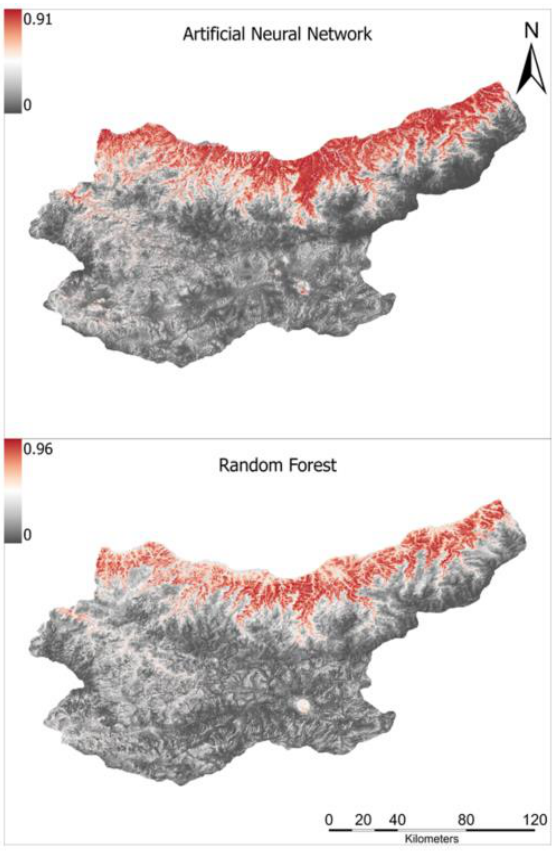
Figure 6. Forest fire susceptibility maps obtained from the ANN (above) and the RF (below).